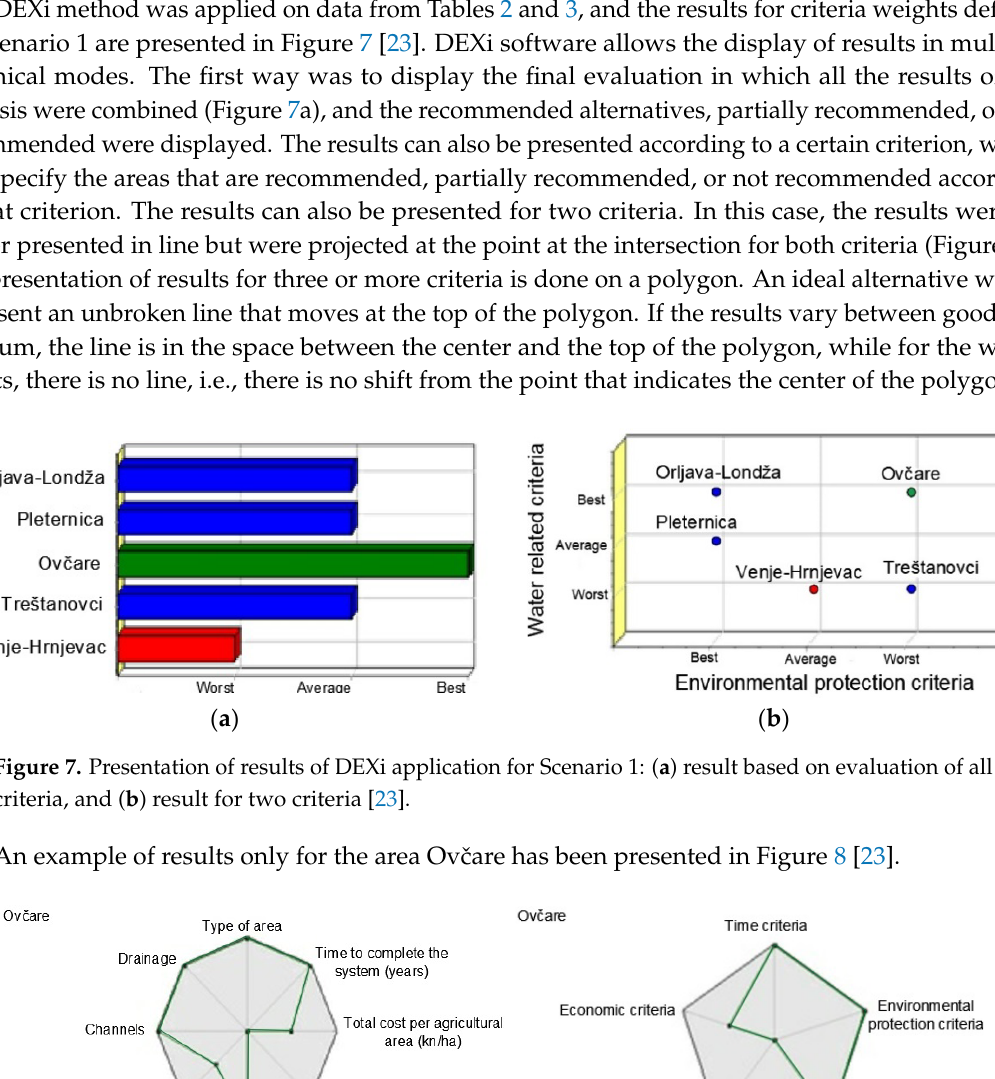
Table 8. Results of ELECTRE TRI for Scenario 1.